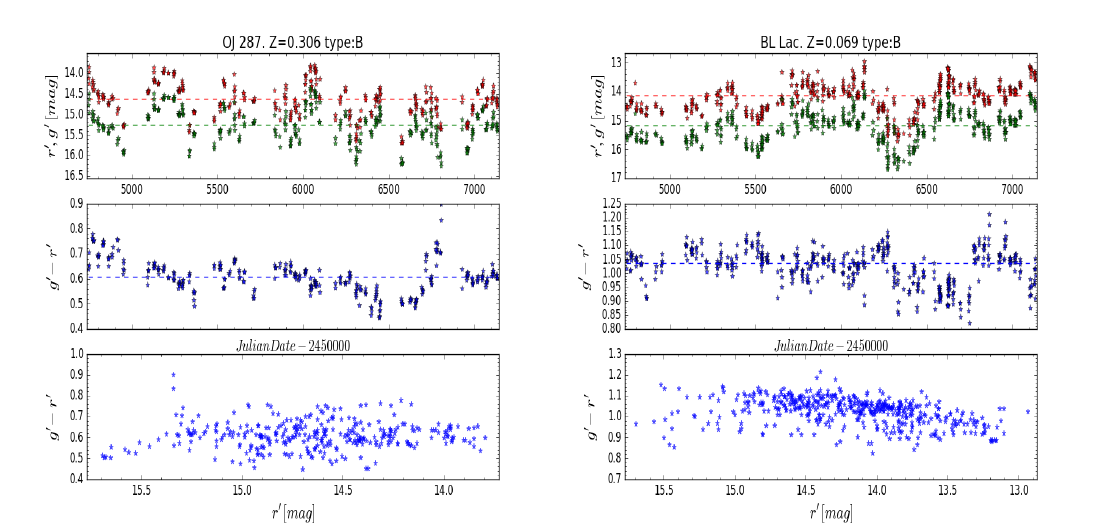
Figure 6. Colour light curves for two BL Lac type objects, similar to Figure